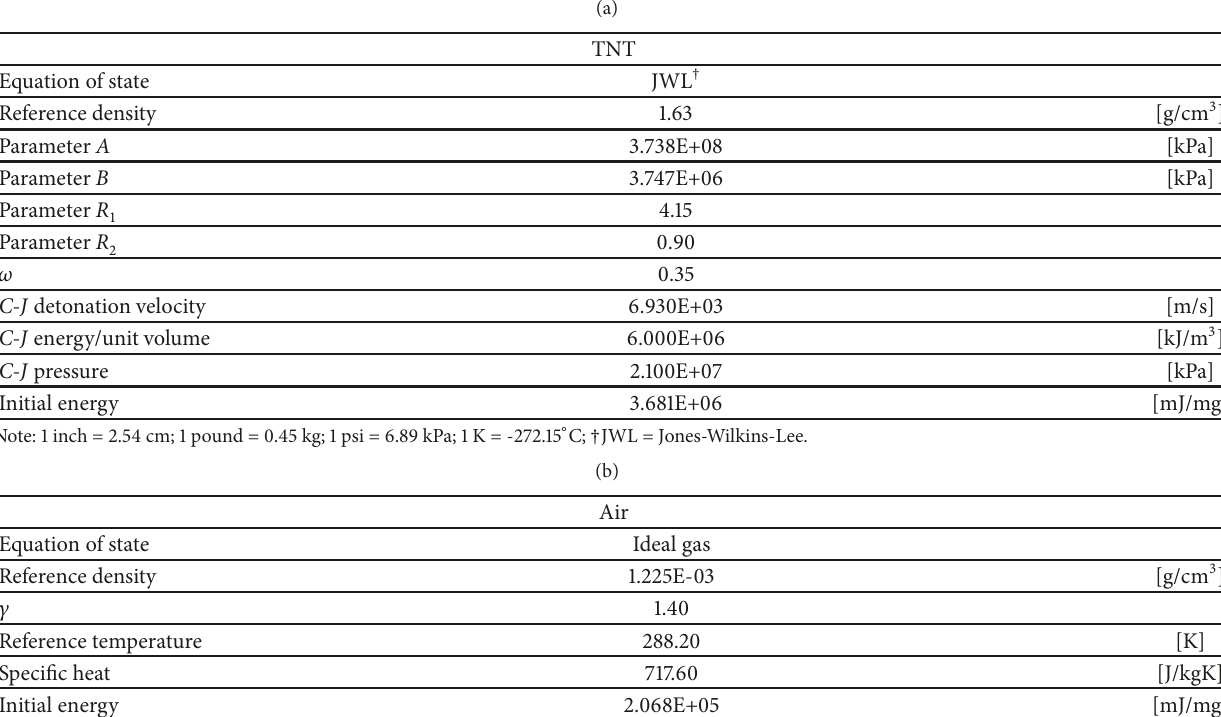
Table 3: Material properties.